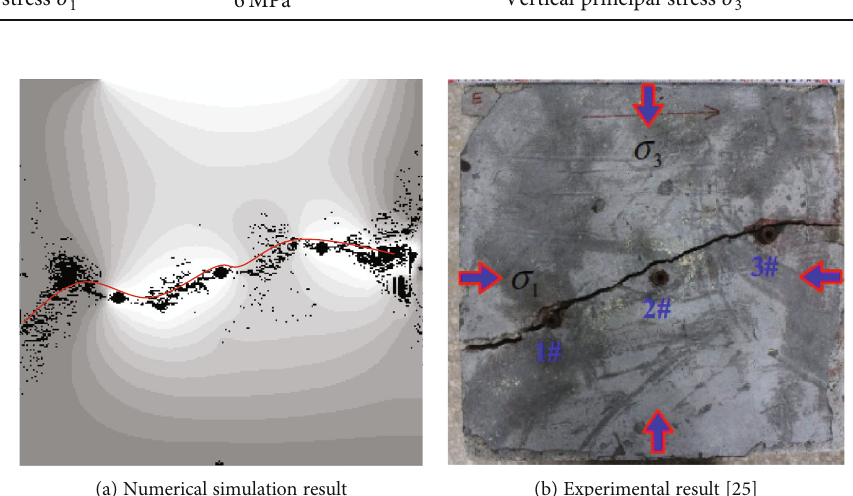
Figure 2: Comparison of numerical simulation and experimental